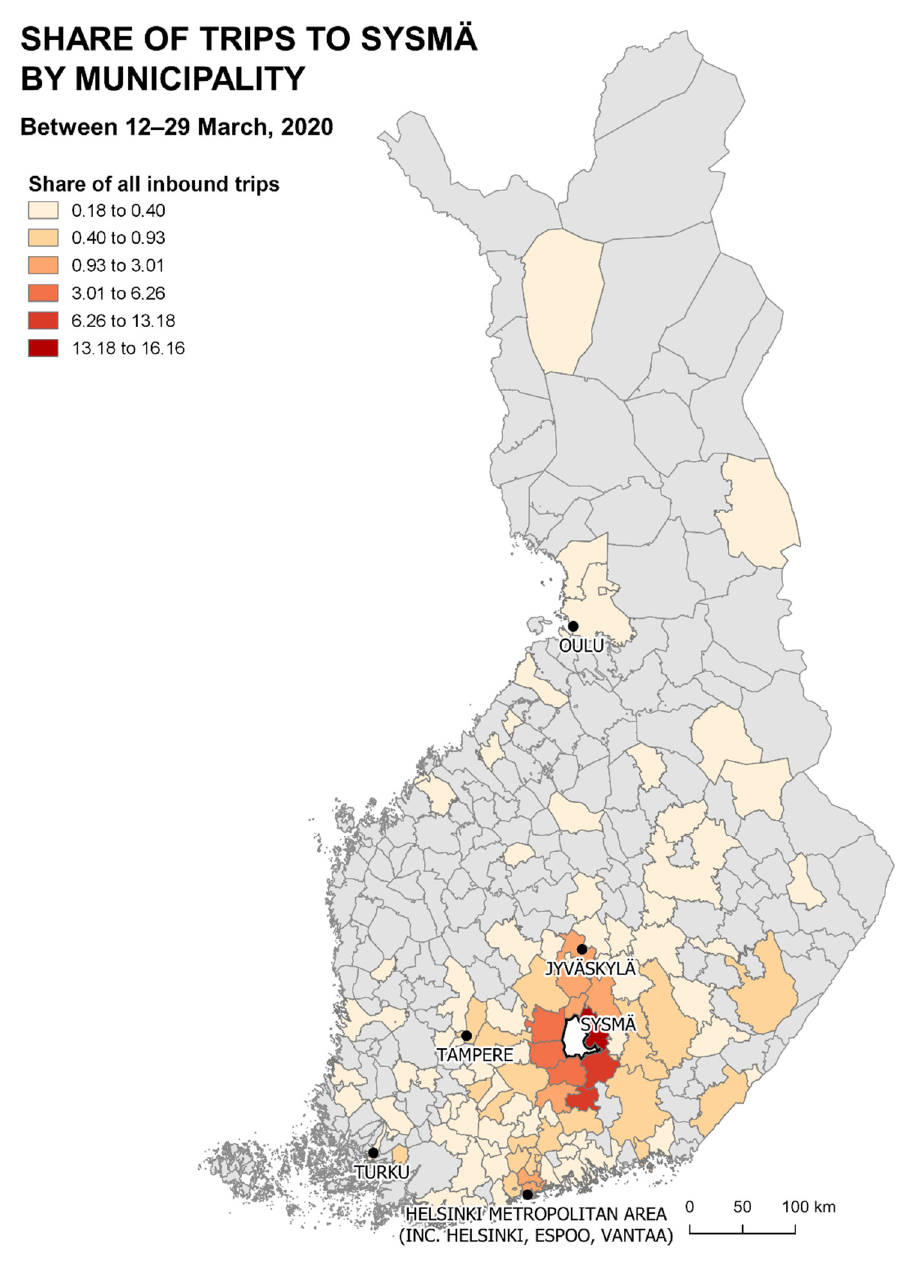
Figure A2. Incoming trips to Sysmä by municipality on 12–29 March, 2020, based on Telia trip data.